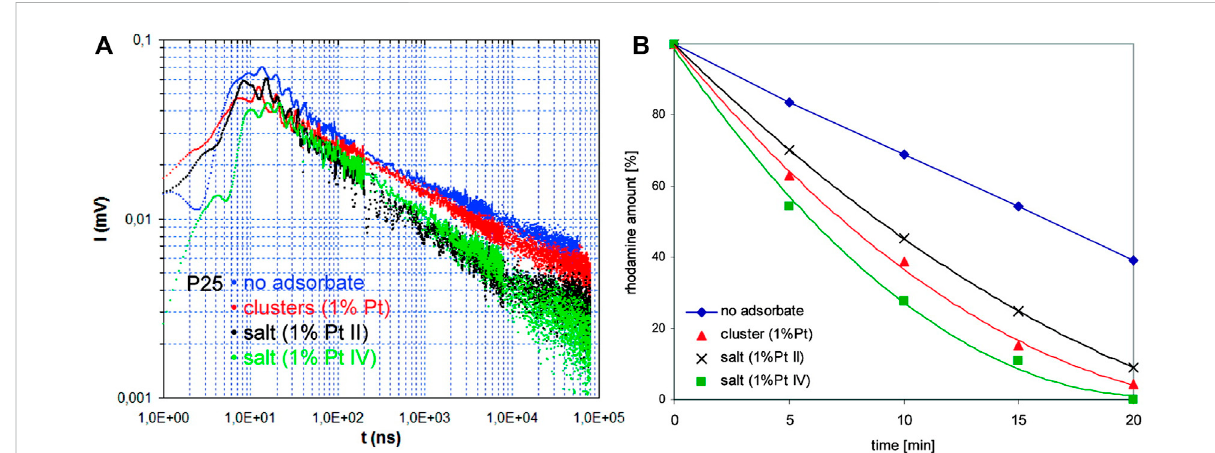
FIGURE 3 Experimentalevidenceforelectrons ’ scavengingbydepositedplatinumonthetitaniasurface(platinumoriginatedfromplatinumsaltsandChini clusters): (A) TRMCresults,and (B) photocatalyticactivitydataforoxidativedecompositionofrhodamineB.Adaptedfrom(Kowalskaetal.,2008)with permission from